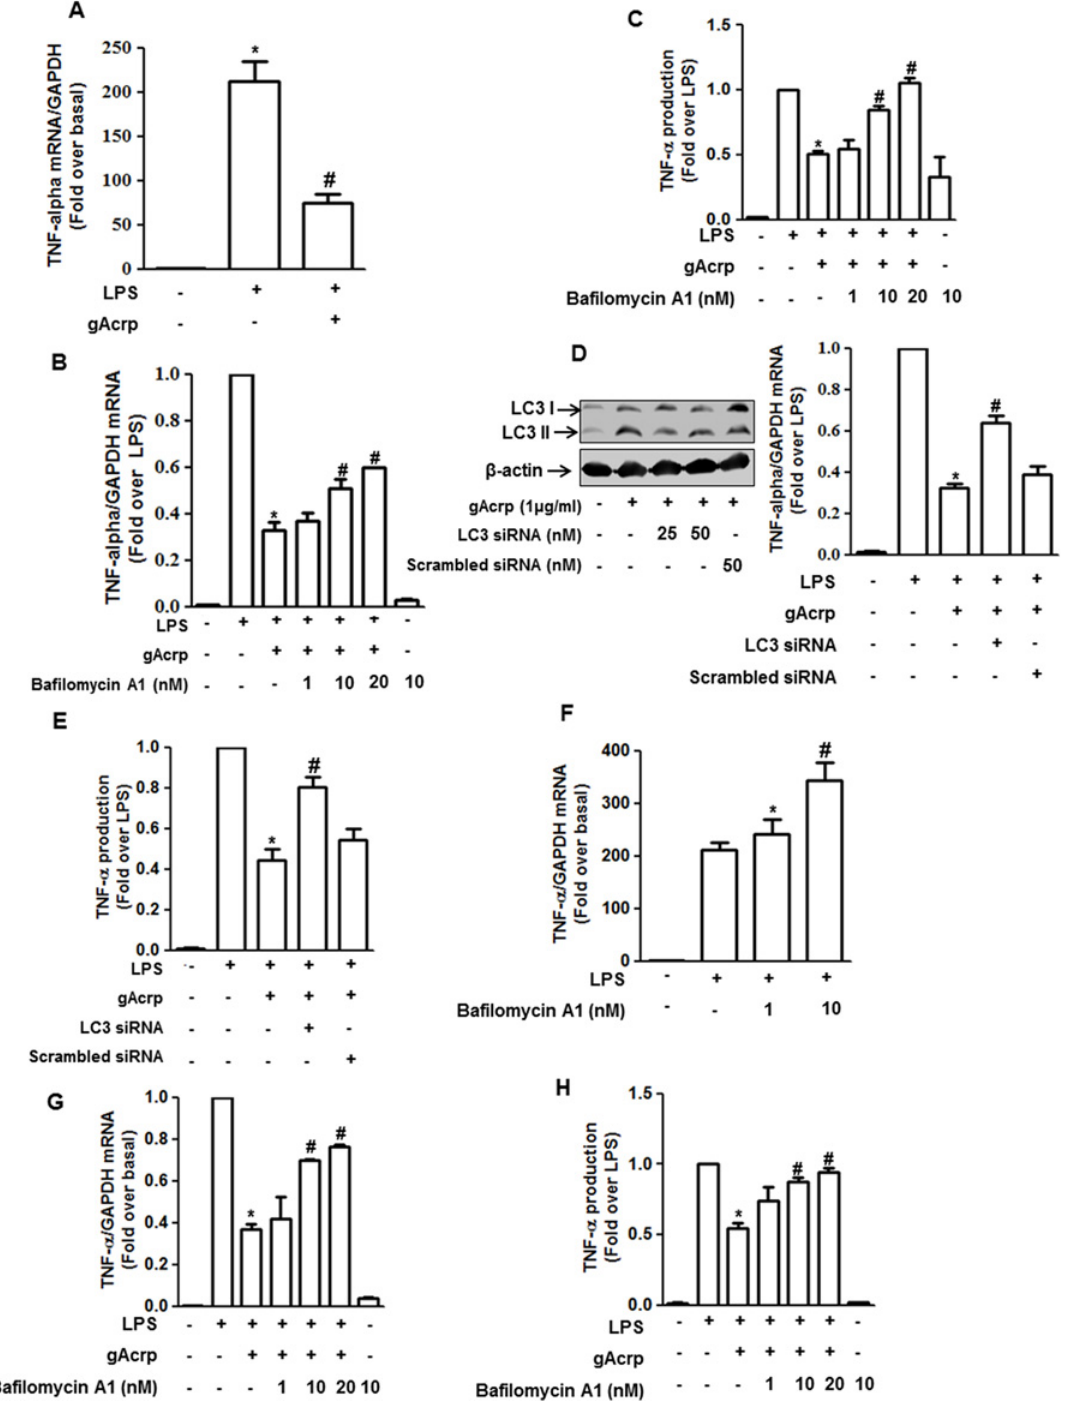
Fig 3. Role of autophagy in suppression of LPS-induced TNF- α expression by gAcrp in RAW 264.7 macrophages and peritoneal macrophages. (A) Cells were pretreated with gAcrp (1 μ g/ml) for 24 h, followed by treatment with LPS (100 ng/ml) for additional 2 h. TNF- α mRNA level was assessed by qRT-PCR as described in materials and methods and normalized to GAPDH mRNA. Values represent fold increase compared with control cells and are expressed as mean ± S.E.M (n = 6). * P < 0.05 compared with untreated cell; # P < 0.05 compared to cells treated with LPS. (B) Cells were pretreated with Bafilomycin A1 (a selective autophagosome-lysosome inhibitor) for 2 h in the absence or presence of gAcrp (1 μ g/ml) followed by stimulation with LPS (100 ng/ml) for additional 2 h. TNF- α mRNA expression was measured by qRT-PCR as described previously. Values represent fold change relative to LPS- treated cells and are presented as mean ± S.E.M. (n = 7). * P < 0.05 compared to cells treated with LPS; # P < 0.05 compared to cells treated with LPS and